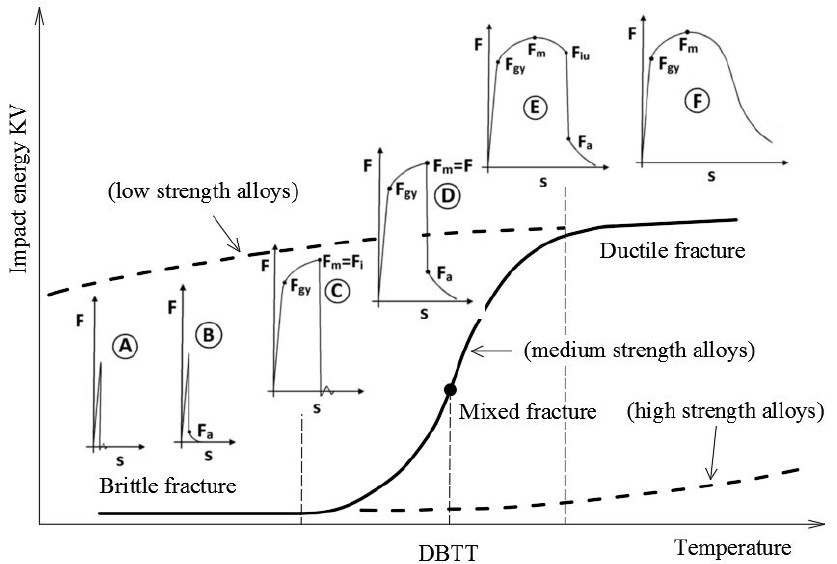
Figure 2. Location of standard 𝐹 − 𝑠 curves on 𝐾𝑉 − 𝑇 graph (description in the text).